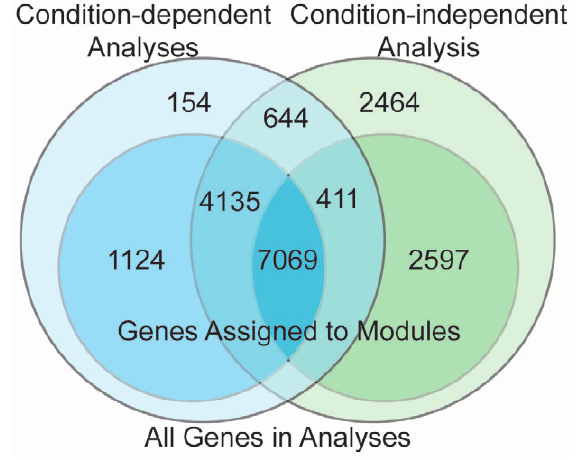
Figure 3. A Venn diagram showing the intersections of genes used in condition-dependent and condition-independent co- expression analyses. The blue circles on the left represent the combined results from the condition-dependent coexpression analyses. The green circles on the right represent the results from the condition- independent analysis. The inner and outer circles respectively represent the genes that were assigned to modules and those that were not assigned to modules in each of the analyses,